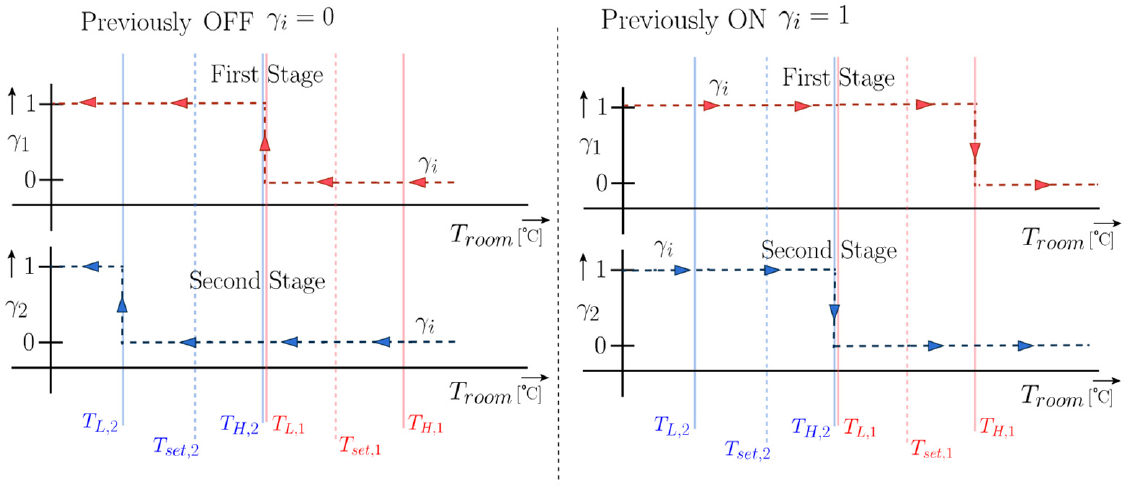
Figure 7. Control schematic of the two-stage room thermostats.